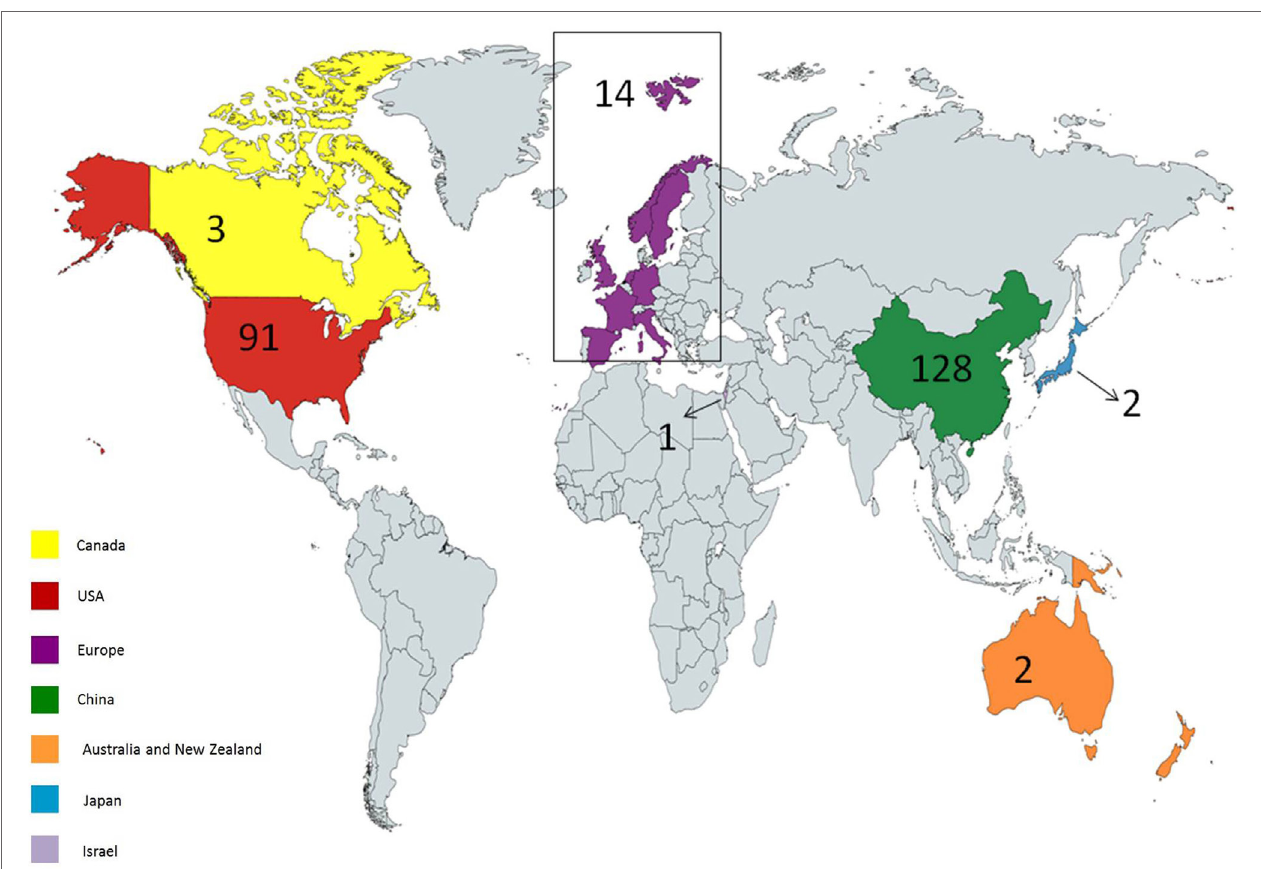
FiGURe 3 | Geographical distribution of ongoing chimeric antigen receptor (CAR) T cell therapy clinical trials for cancer. USA and China hold most of the trials; however, other countries have also considered holding trials. Created by Esmaeilzadeh et al.